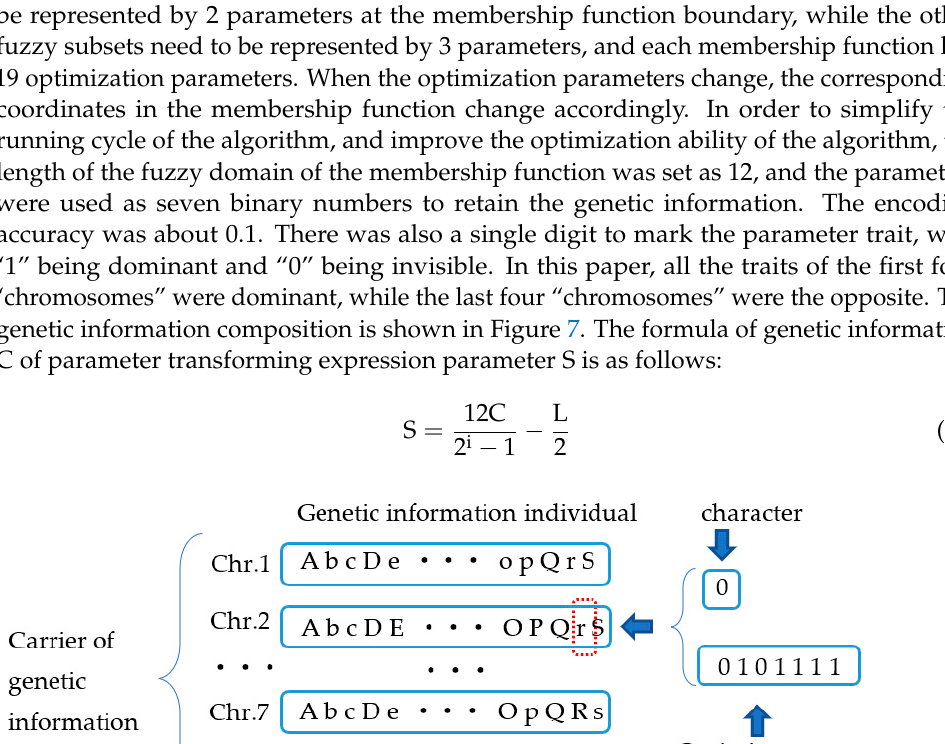
Figure 6. ( a ) Algorithm iteration scheme I; ( b ) Algorithm iteration scheme II.